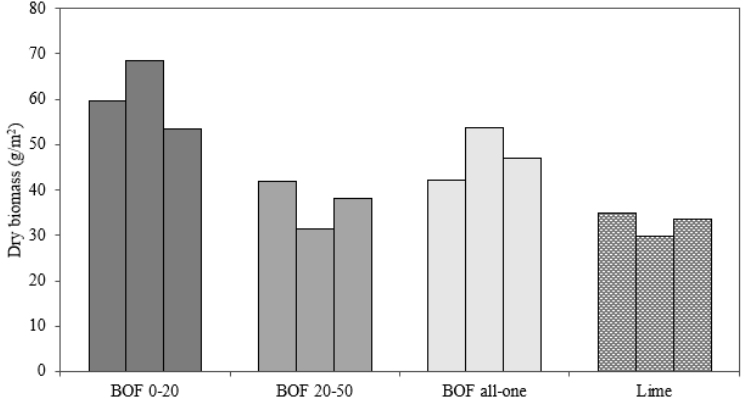
Figure 3. Dry biomass of all samples (g m − 2 ).